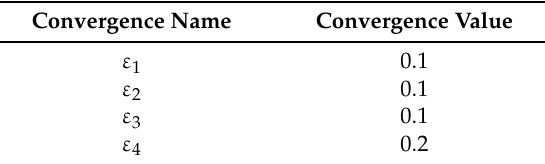
Table 2. Convergence value for iteration loops.